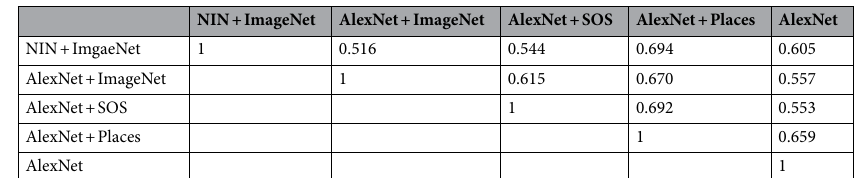
Table 2. AlexNet + SOS test results according to inclusion or exclusion of fully connected layers in weight transfer.